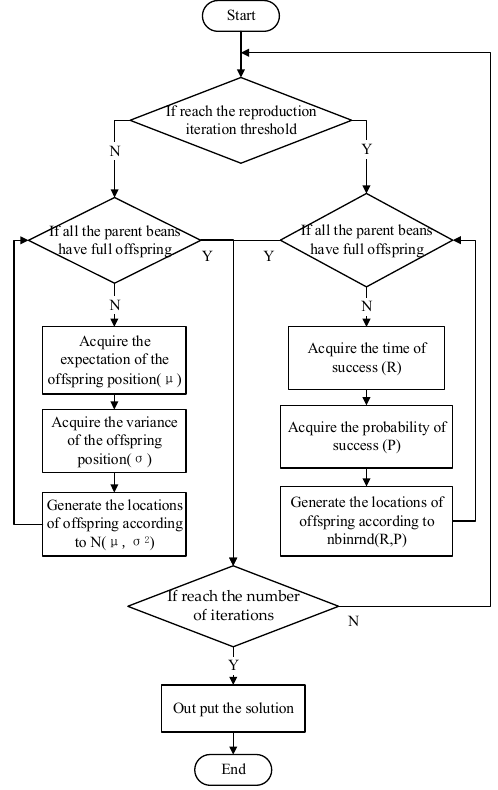
Figure 1. Flowchart for generating offspring.